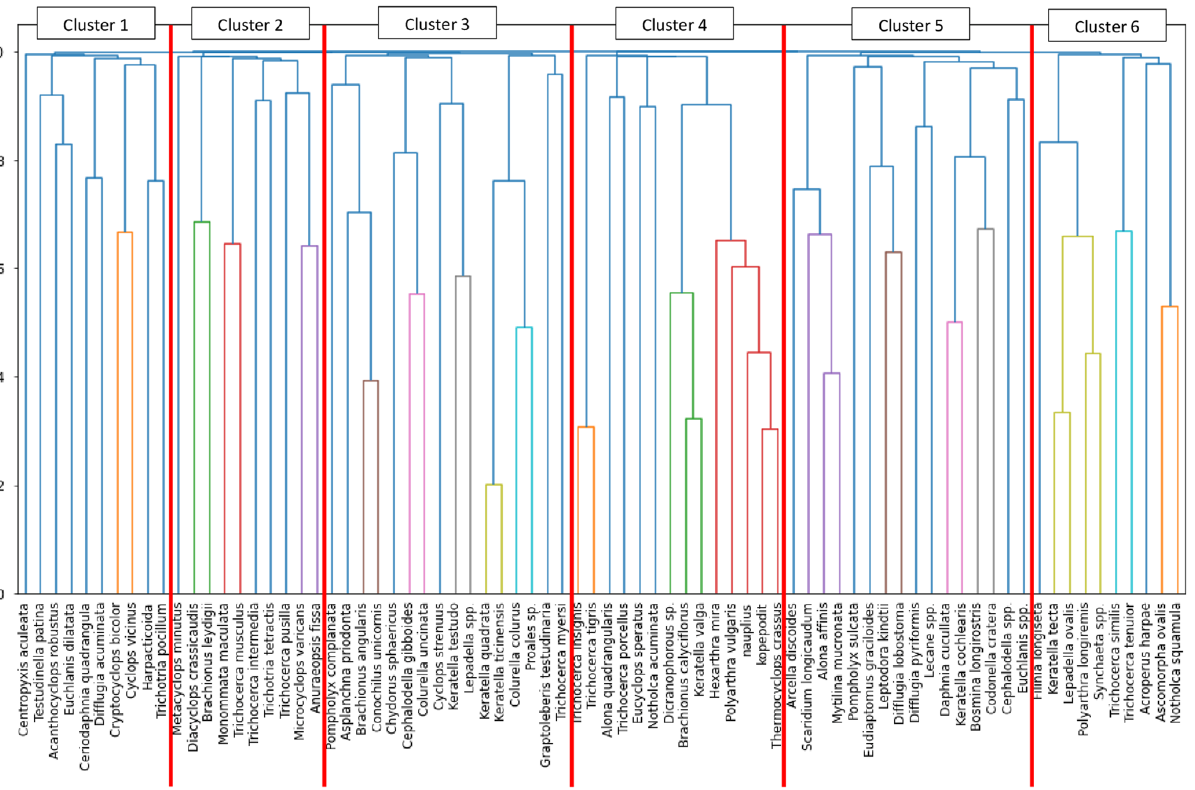
Figure 2. The dendrogram of the hierarchical clustering of the zooplankton taxa of the Cold and Warm Lakes. The threshold for 6 clusters is 0.998. Results of the dendrogram metrics: Silhouette Score: 0.425, Calinski- Harabasz Score: 129.2807 and Davies Bouldin Score: 0.7925. A sequence of 9 colours, except deep blue, indicates the smaller clusters with a distance threshold of 70% of the final merge (Python library Scipy